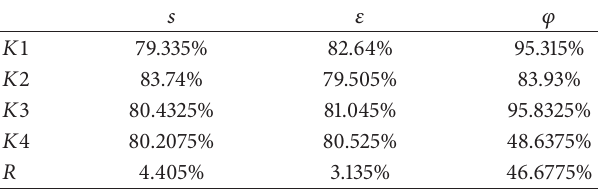
Table 4: 𝐾 and 𝑅 for propulsive efficiency.